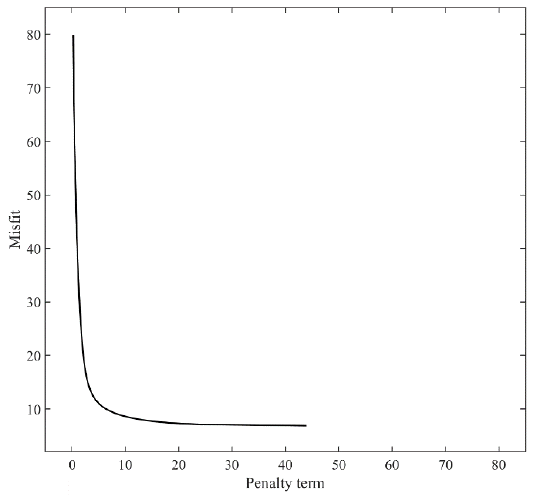
Figure 13. Trade-off curve under different values of µ .